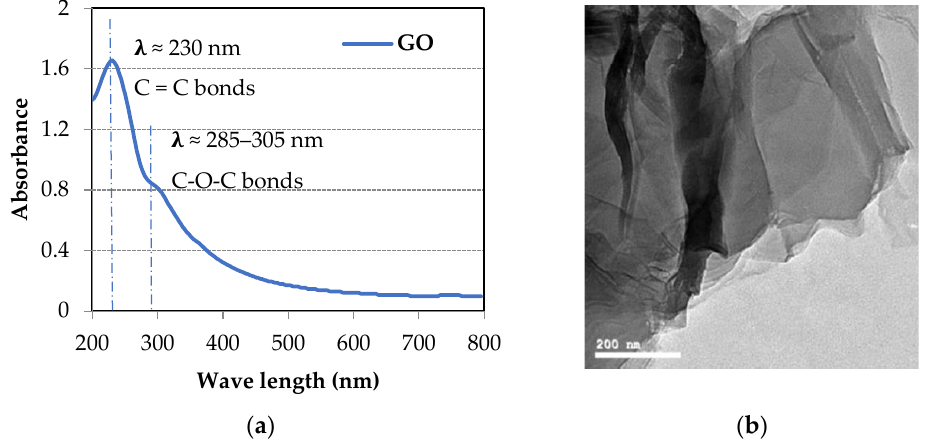
Figure 2. ( a ) UV – vis spectrum; ( b ) TEM image of GO sheets. Figure 2. ( a ) UV–vis spectrum; ( b ) TEM image of GO